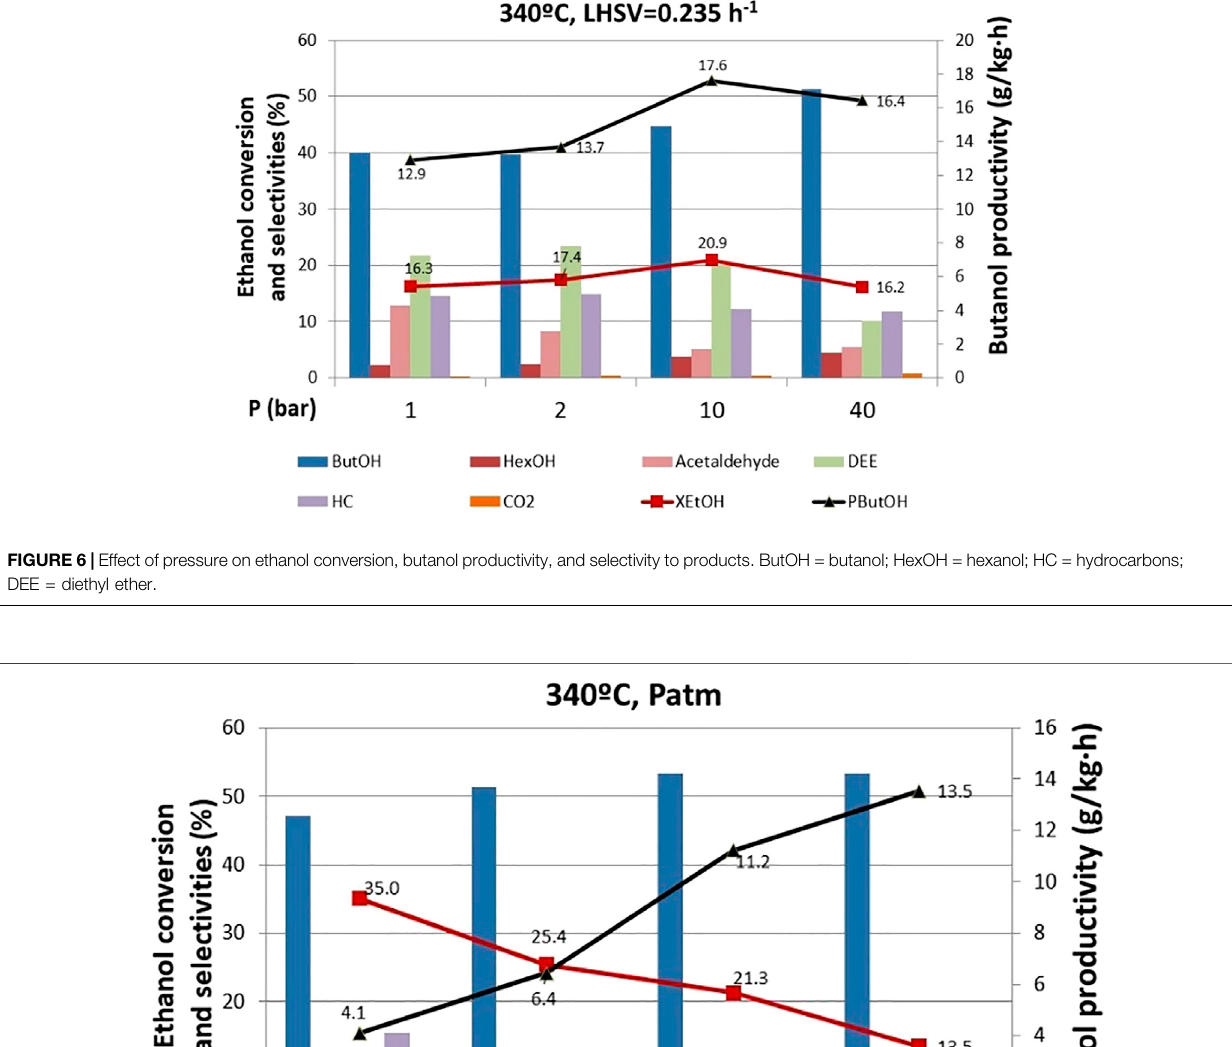
Frontiers in Chemistry |